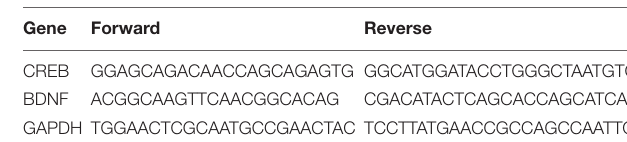
TABLE 3 | The primers for Quantitative RT-PCR.